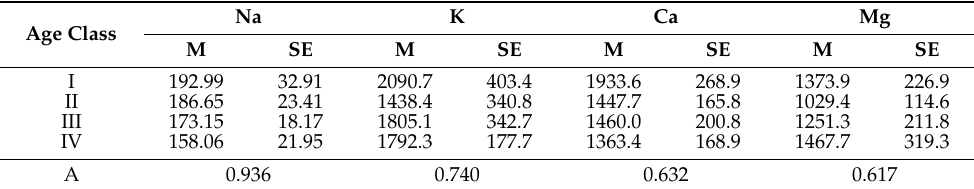
Table 3. Mean (M) with standard error (SE) stocks (kg/ha) of the macroelements in the top (0–30 cm) soil layer under silver birch regeneration by age class.